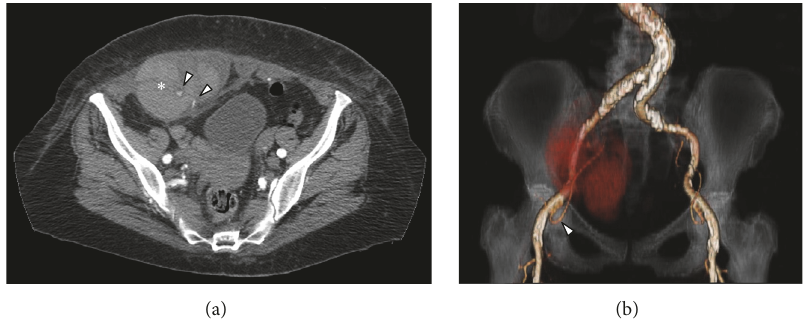
Figure 1: (a) MD-CT axial view demonstrates the presence of a haematoma into the right rectus sheath ( ∗ ) with two spots of active bleeding from distal collaterals of the right inferior epigastric artery (arrowheads). (b) MD-CT coronal Volume Rendering Technique image with right inferior epigastric artery reconstruction (arrowhead) and the haematoma into the right rectus sheath as a red shadow.